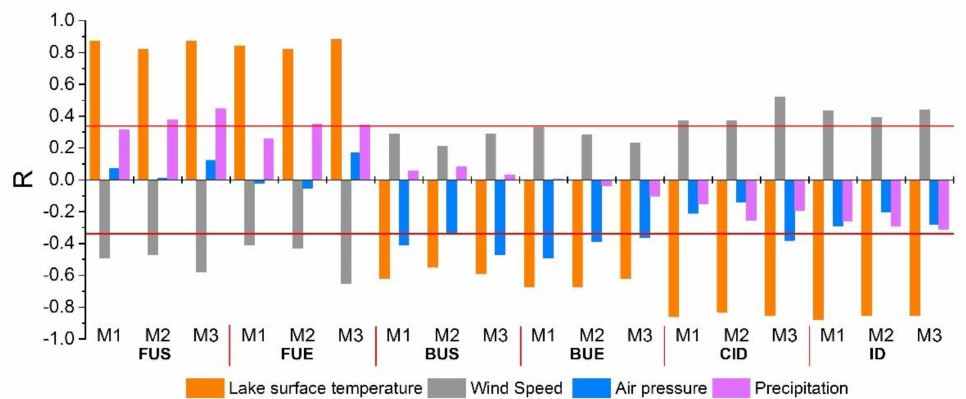
Figure 3. Spatial correlation between lake ice phenology and environmental factors (M1, M2, and M3 respectively represent the methods described in Sections 3.1–3.3; red line represents the correlation coefficient corresponding to p = 0.05). The lake surface temperature is the mean of temperature of the period from December to May obtained from the MODIS LST product; wind speed, air pressure, and precipitation data were obtained from